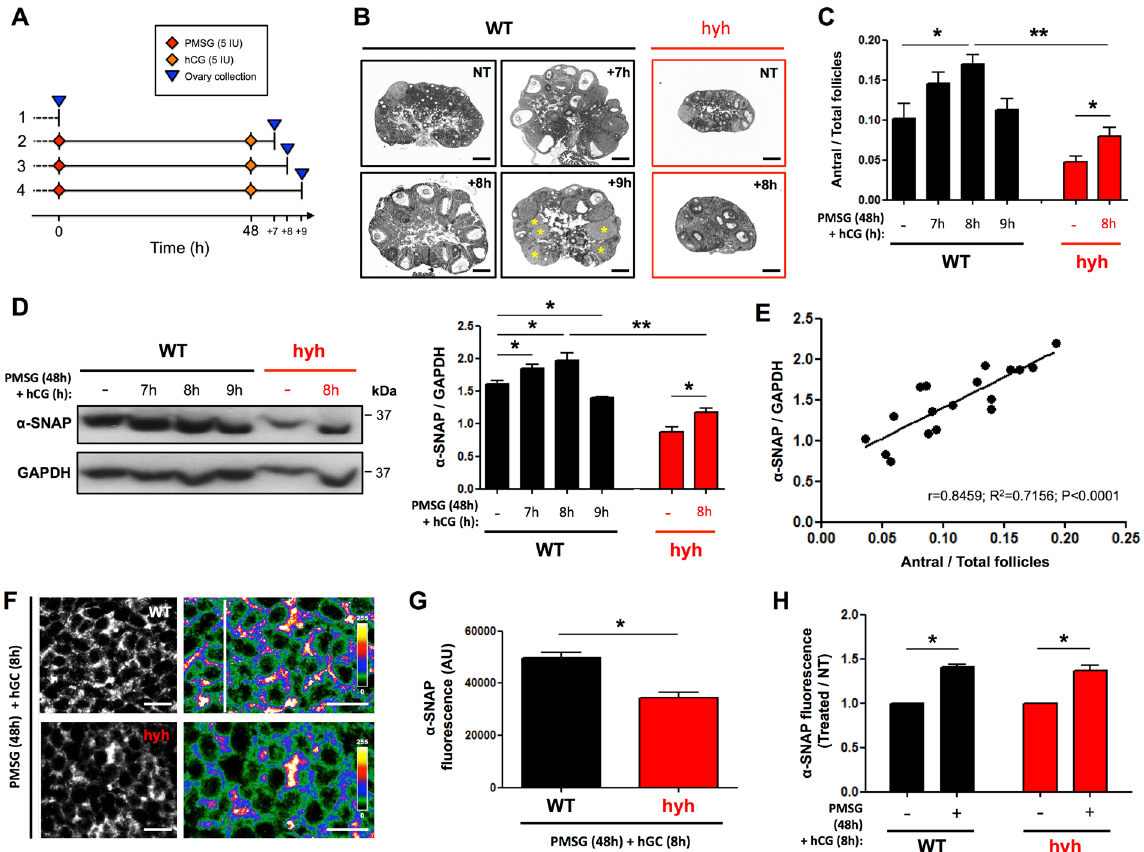
Figure 2. Expression of α -SNAP in ovarian tissue and granulosa cells (GCs) after gonadotropin stimulation. ( A,B ). Scheme of the protocol used for gonadotropin stimulation and ovarian tissue collection ( A ), and representative images of hematoxylin-eosin staining of ovary sections ( B ). Wild type (WT) females were divided into four groups: 1, control non-treated females (NT); 2–4, females received gonadotropin stimulation (one i.p. injection of PMSG (5 IU) + one i.p. injection of hCG (5 IU) 48 h after PMSG injection) and ovaries were collected 7 h ( + 7; group 2), 8 h ( + 8; group 3) and 9 h ( + 9; group 4) after hCG injection (see Material and Methods for details). Mutant females were included in protocol 1 (NT) and 3 ( + 8). Note the presence of abundant antral follicles in + 7 and + 8 WT ovaries; on the other hand, several corpora lutea are observed in + 9 ovary (yellow asterisks). Scale bars, 200 μ m. ( C ) Morphometric analysis of antral follicles in WT (black bars) and hyh (red bars) ovaries from control or non-treated females ( − ) and after PMSG + hCG